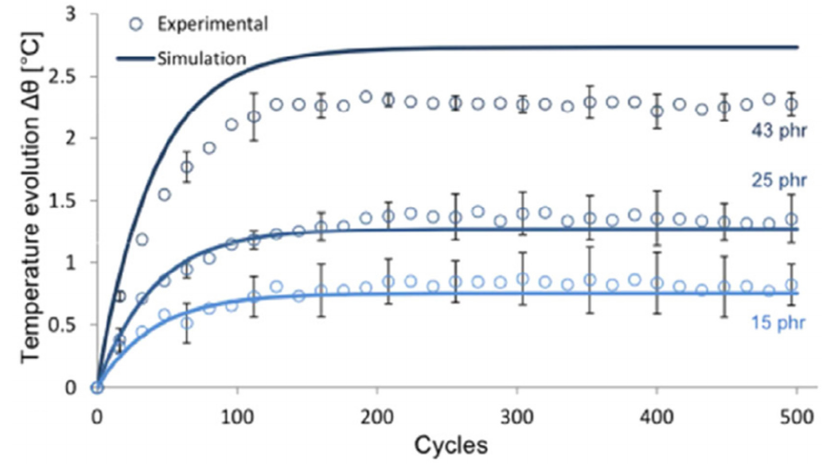
Figure 16. Predicted and experimental temperature rise [80].